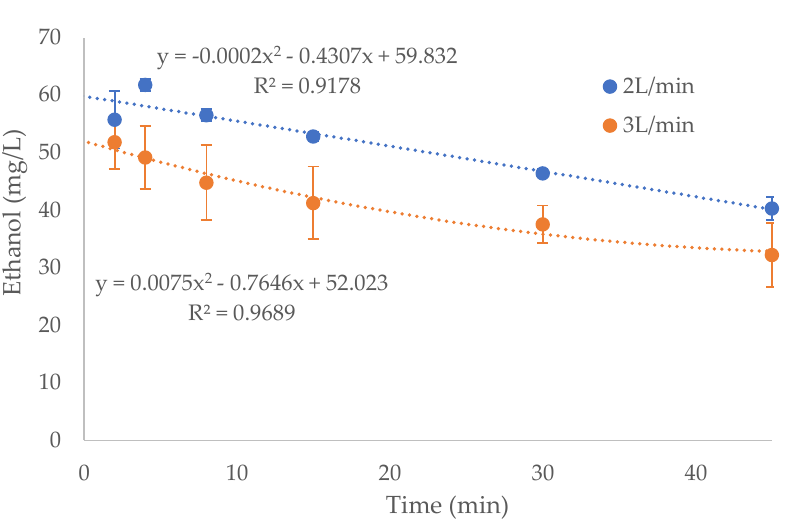
Figure 4. Ethanol concentration (mg/L) in the vapor phase of oxygen generated in the humidifier, during the 45 minutes of treatment, at 2 L/min and 3 L/min.